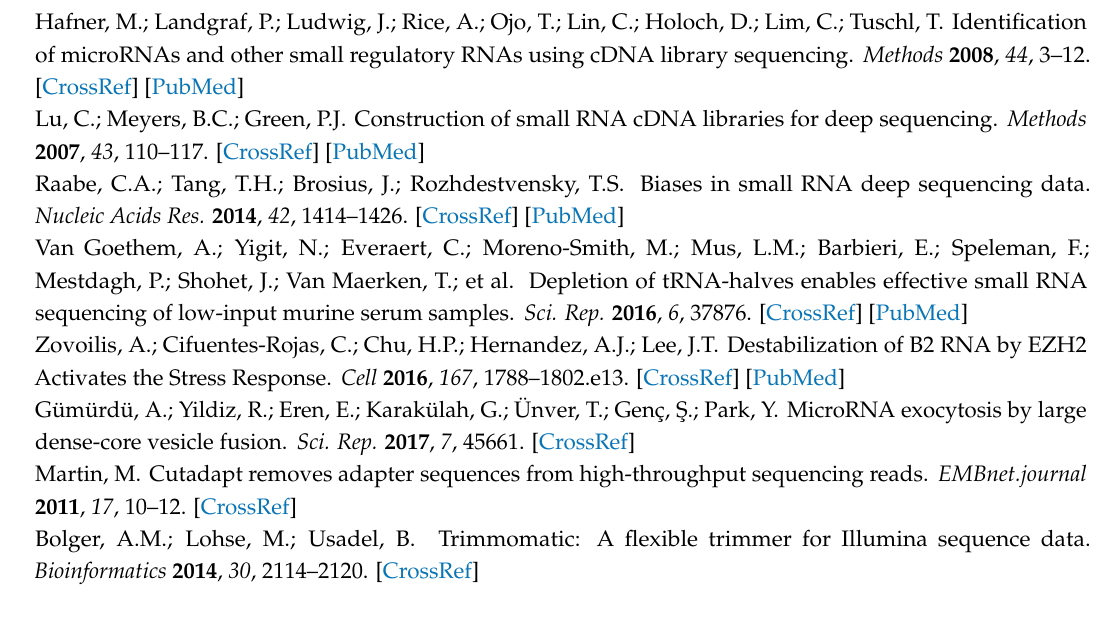
Figure S1: Use of incorrect adapter sequence or trimming protocol can lead to miscounting of reads mapping to features; Figure S2: Trimming analysis results for dataset from [6]. Table S1: 3’ adapters for small RNA-seq kits for the Illumina platform; Table S2: The number of SRA entries that mention library preparation kit in experimental description as of 27 May 2019; Table S3: Predicted adapter sequence from raw sequencing data using three tools, including Minion, DNApi and AdapterRemoval; Table S4: Sequences for the six synthetic oligonucleotides from [15] shown in Figure 1 and Table S5; Table S5: Un-transformed count table for samples in dataset[15] for raw data and using the various adapter sequences as specified in Figure 1; Table S6: Trimming results for top 15 most abundant miRNAs in [6]; Table S7: Datasets used in this analysis. Including their accession number, library preparation kit, sample information and reference; Table S8: Trimming sets generated in the analyses with different adapter sequence and corresponding trimming